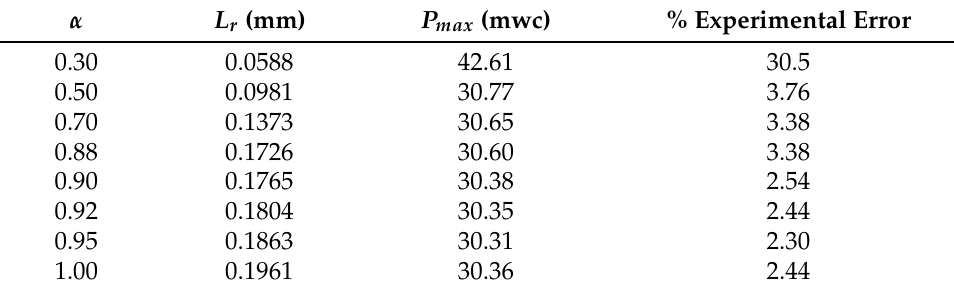
Table 4. R a influence over L r and the peak pressure. Experimental Test